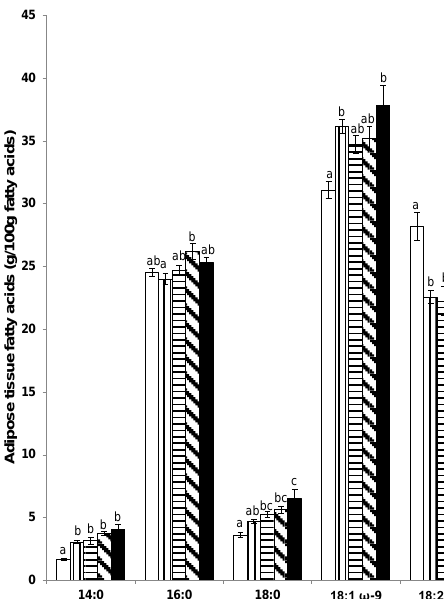
Figure 5. Hepatic fatty acids (g/100 g fatty acids). Numerals refer to the specific week of gestational high fat (HF) maintenance. G, gestation refers to HF maintenance throughout gestation. Values are means ± standard error of the mean (SEM). Different letters reflect significant changes.